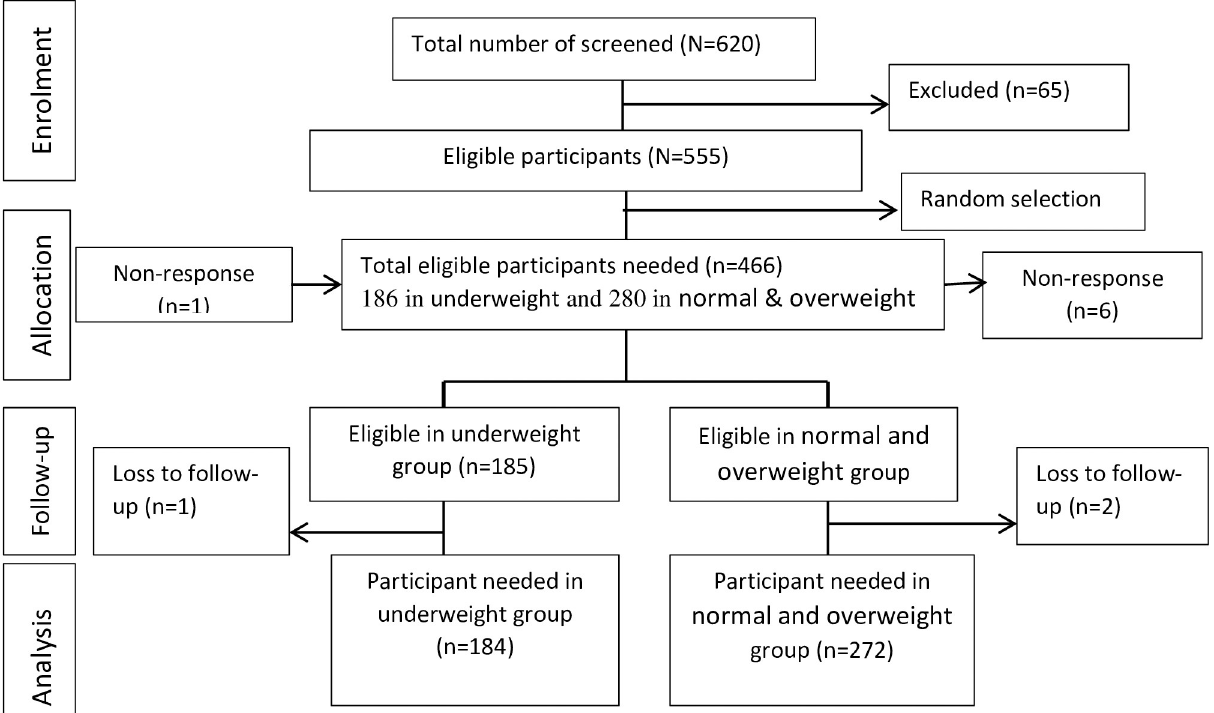
Fig 1. Schematic presentation of the sampling process among adult TB patients at Addis Ababa, Ethiopia, 2019.